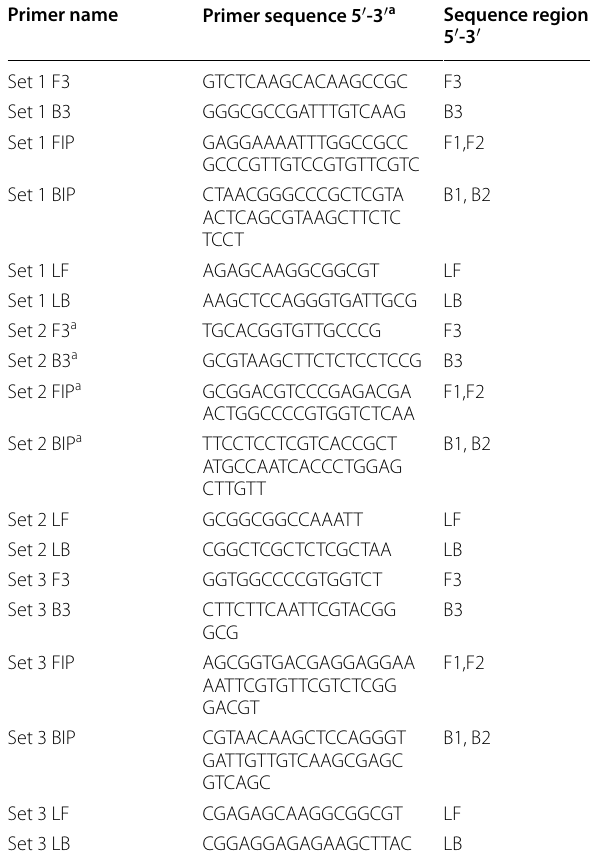
Table 6 Loop-mediated isothermal amplification primers used for Austropeplea tomentosa detection in this study